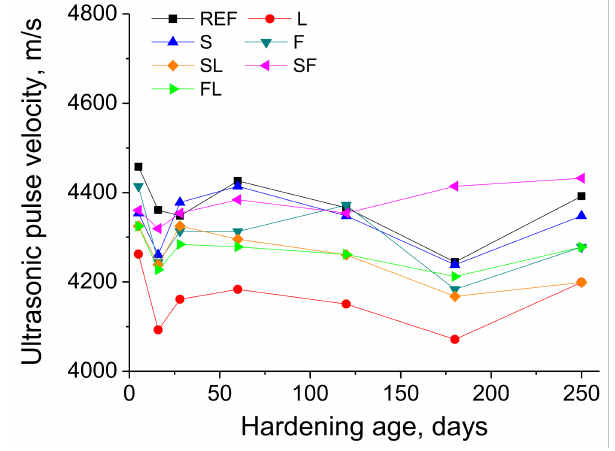
Figure 14. Ultrasonic pulse velocity results observed for the different types of mortars